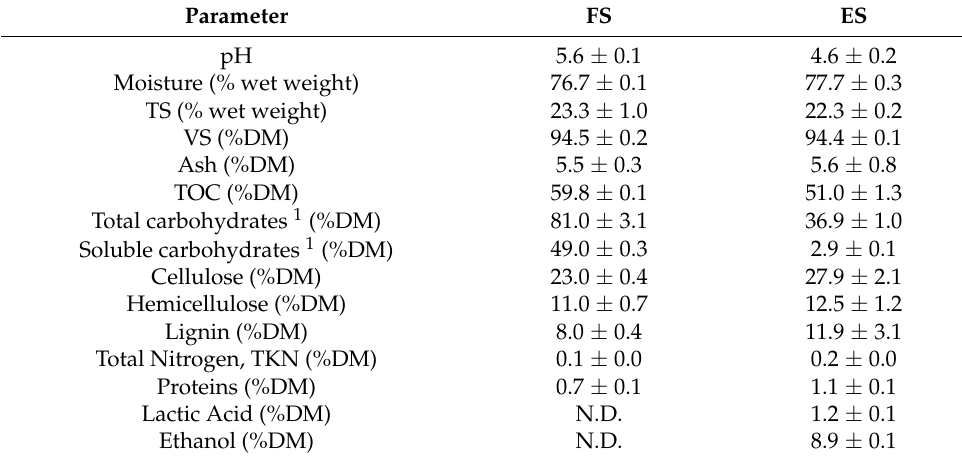
Table 2. Chemical composition of FS and